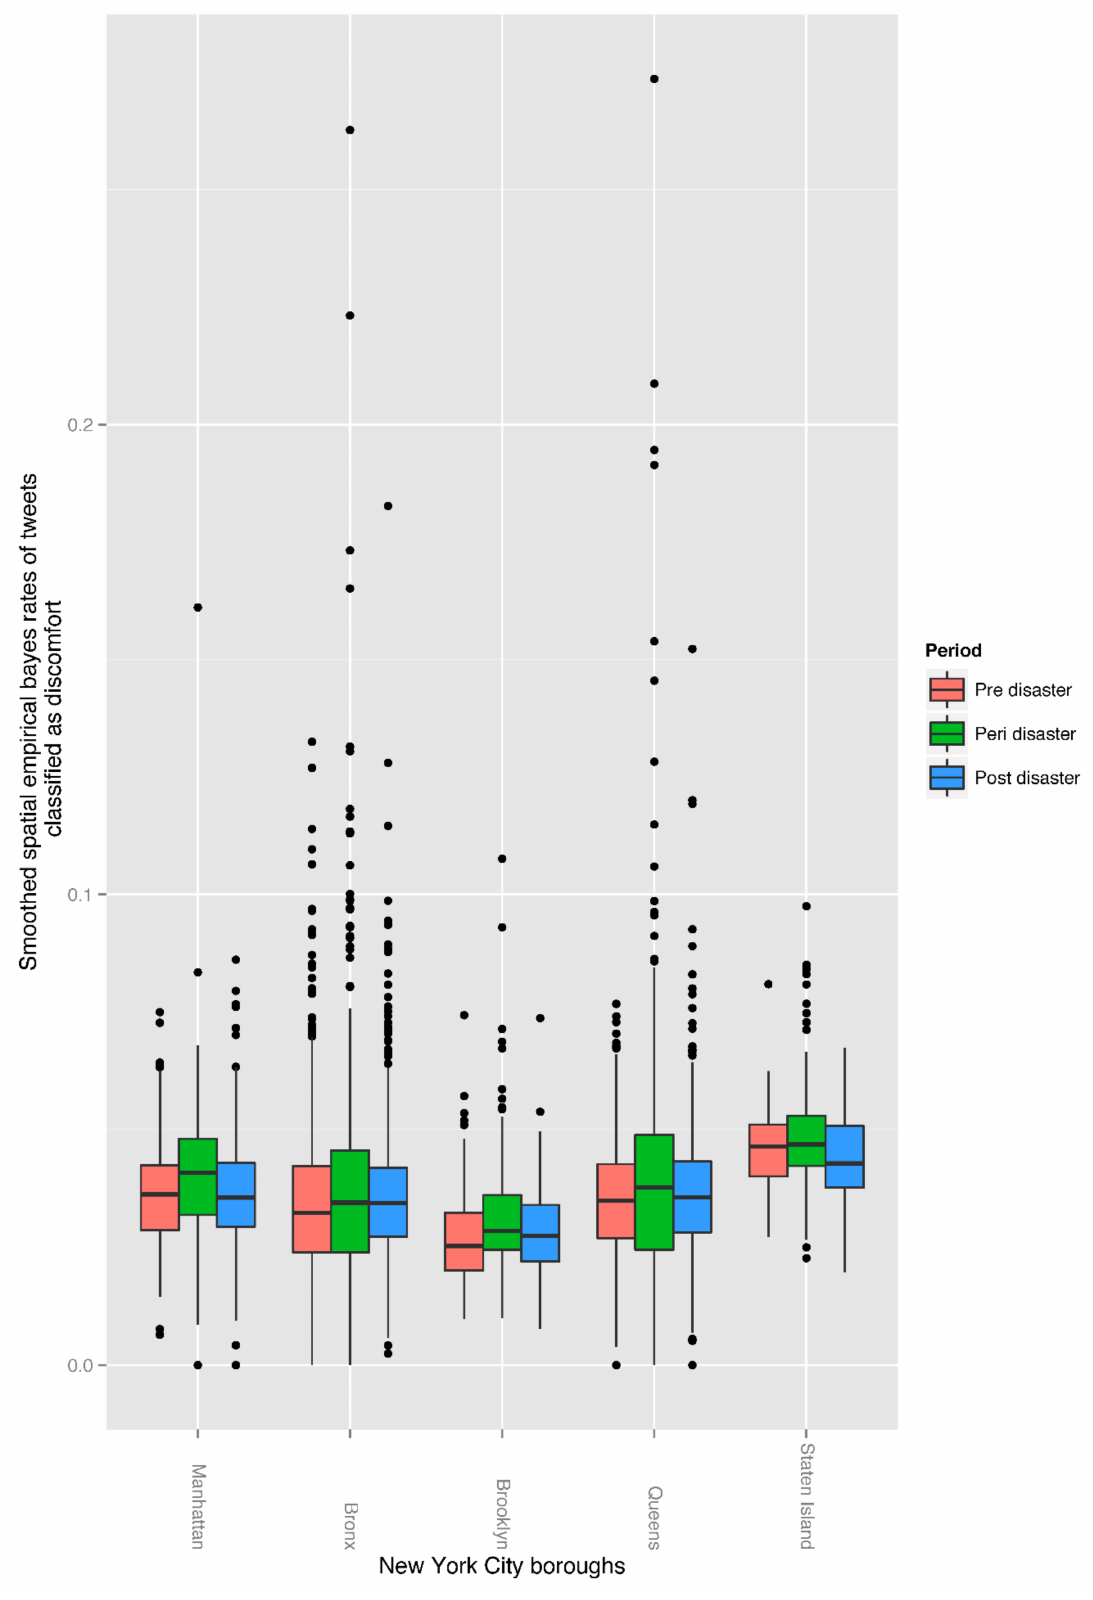
Figure 1. Spatial Empirical Bayes smoothed rates of tweets classified as discomfort for each NYC borough across time